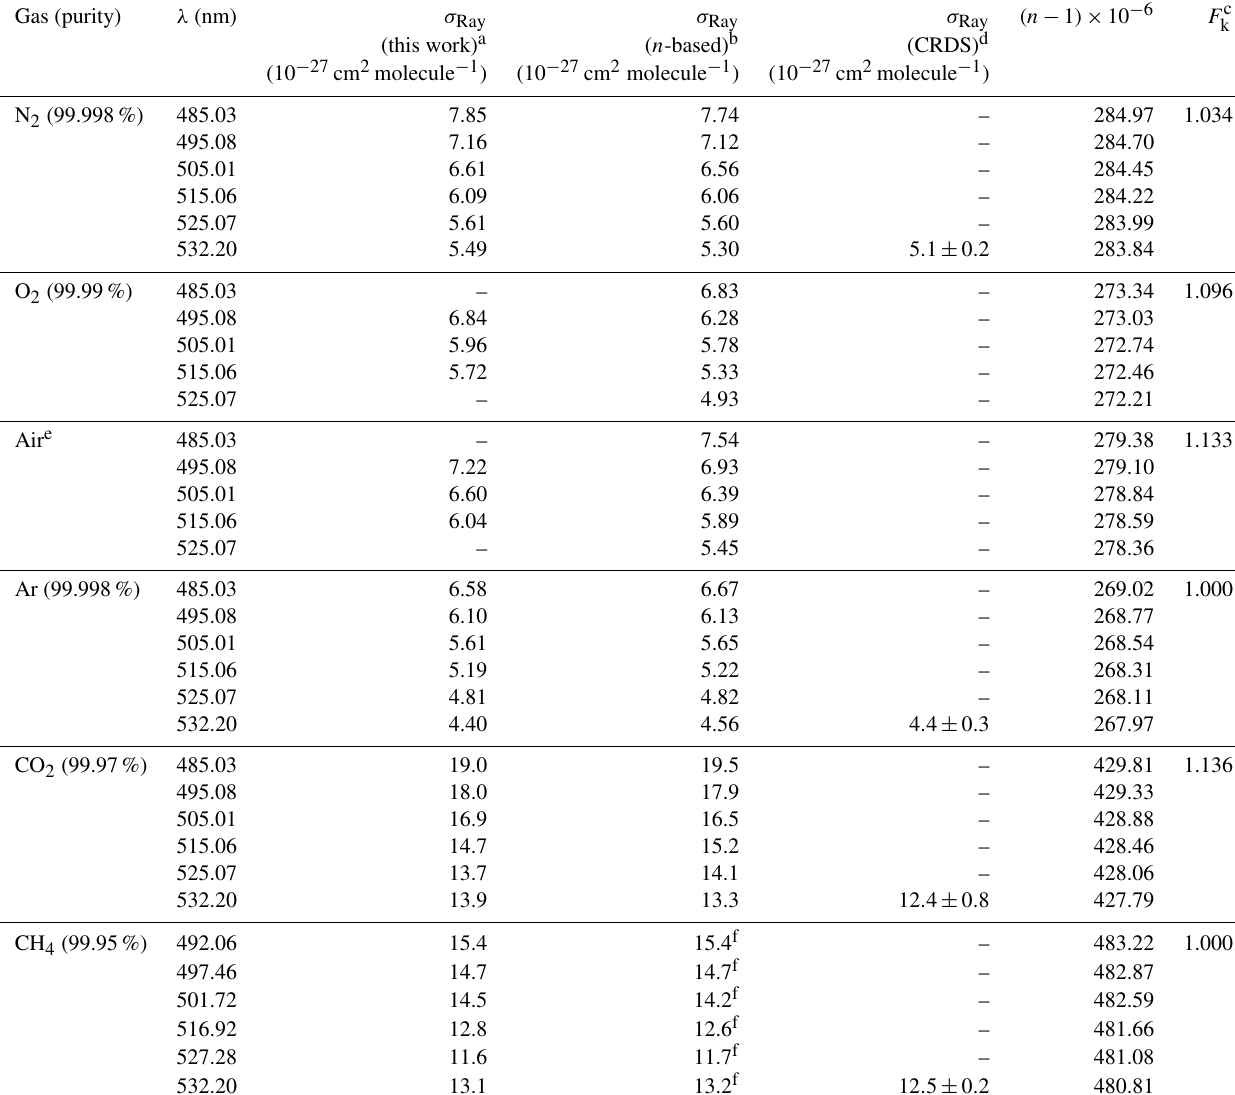
Table 1. Summary of observed and n -based Rayleigh scattering cross sections. Gas